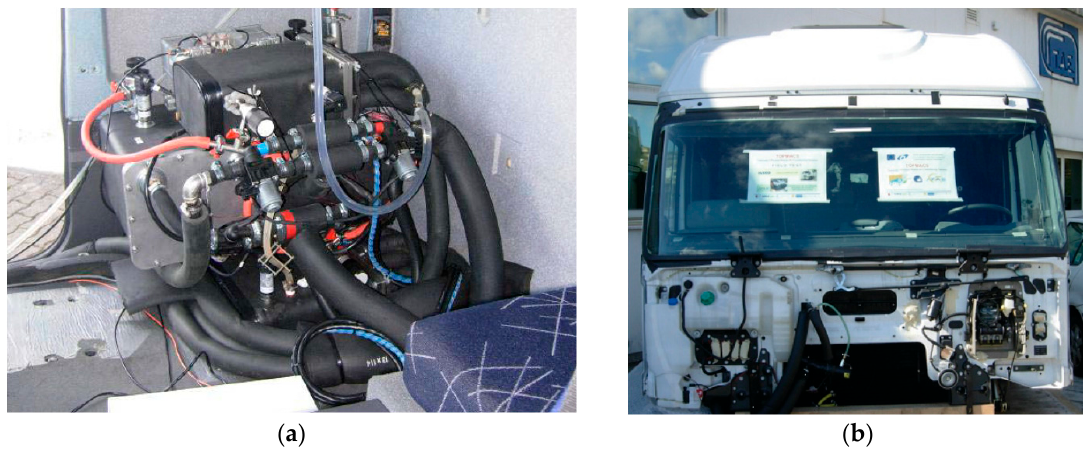
Figure 11. The adsorption system installed in the cabin of the truck for field tests [8]. ( a ) Adsorption system prototype and ( b ) adsorption system installed in the truck cabin.